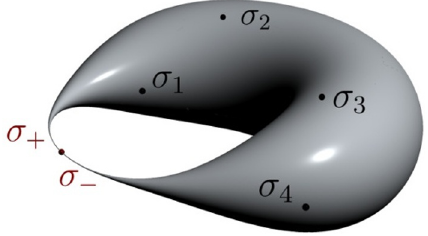
Figure 7 . The nodal sphere with four punctures corresponding to external particles. The node is parametrised by two additional marked points (cid:27) + and (cid:27) (cid:0)